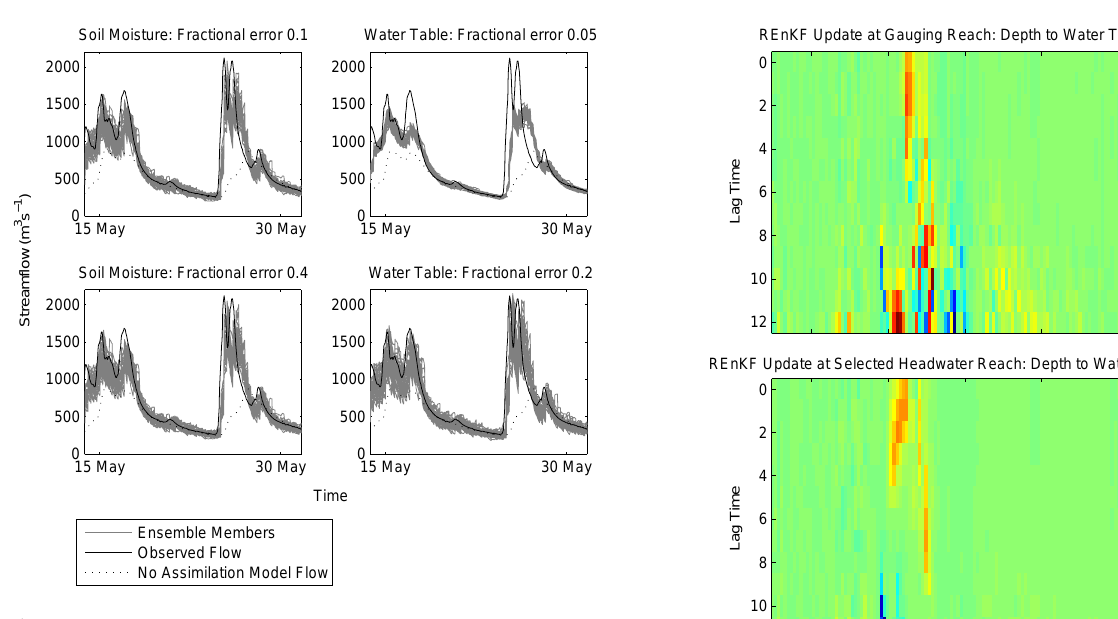
Fig. 11. Streamflow ensemble spread during an example REnKF model run showing a comparison of fractional error parameters for (left panels) soil moisture and (right panels) depth to water table. Series shown for the Grey catchment at the gauging location. En- semble members are shown in grey, observed streamflow in black, modelled streamflow without assimilation as dotted line.